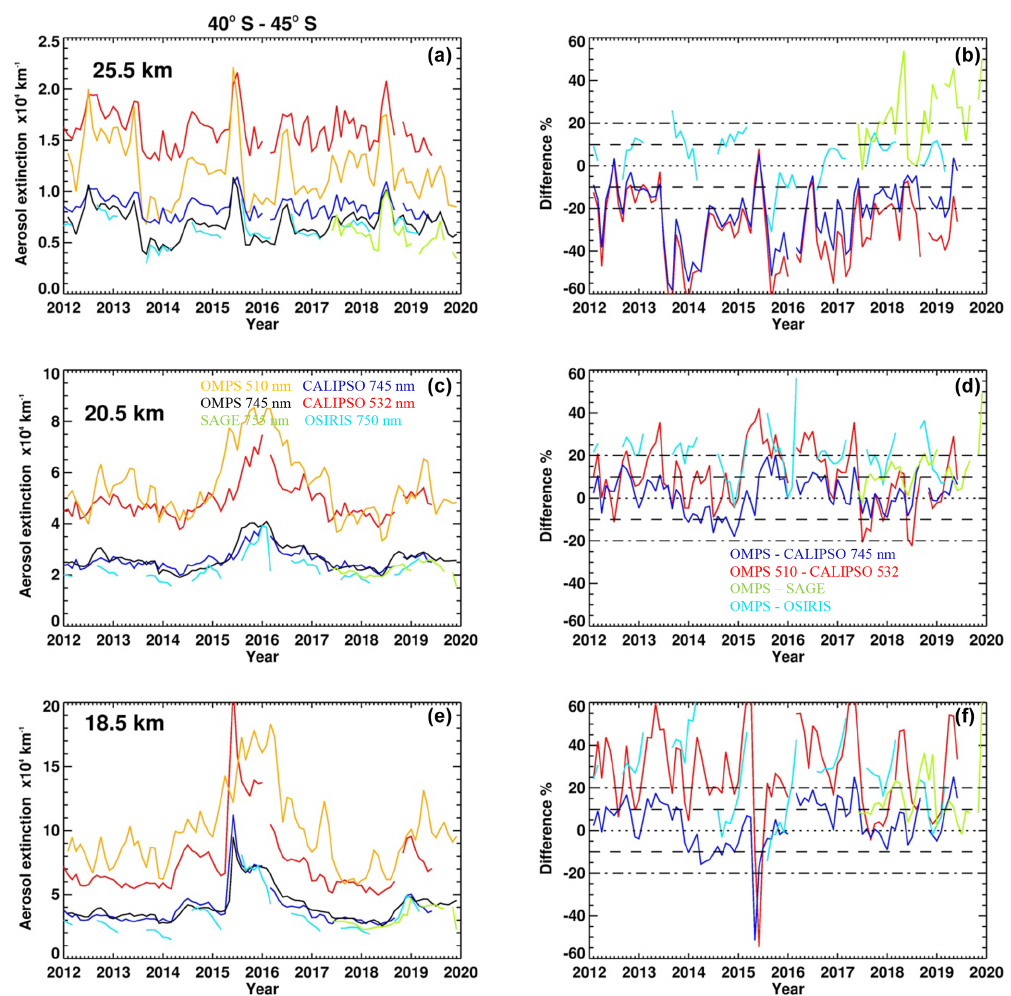
Figure 12. Panels (a) , (c) and (e) are CALIPSO 532 (red) and 745 (blue), OMPS LP 510 (orange) and 745 (black), OSIRIS 750 (light blue), and SAGE III/ISS 755nm (green) aerosol extinction monthly zonal mean, latitude zone 40–45 ◦ S for altitudes 25.5 (top), 20.5 (middle) and 18.5km (bottom), from 2012 to 2019. Panels (b) , (d) and (e) are the percent difference between OMPS LP and other